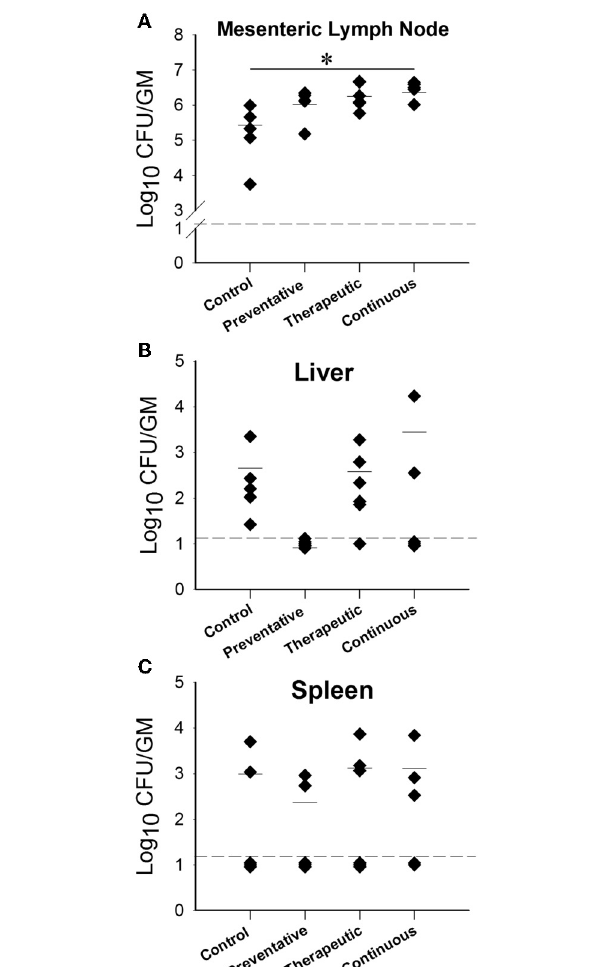
FIGURE 7 | Cytokine profiles of different Lactobacillus casei ATCC 334 treatments at 12 weeks post oral M. avium subsp. paratuberculosis K10 infection. Graphs A–C ( A . INF γ , B . IL-10, C . IL-12) depict cytokine levels of mice orally infected with two consecutive doses of 10 9 CFU of M. avium subsp. paratuberculosis K10 and treated with different ATCC 334 treatments. At 12 weeks post infection, mouse spleens were collected and splenocytes were isolated and stimulated with Johnin Purified Protein Derivative (PPD) or media only for 48h. Supernatant was collected and used for cytokine quantification by luminex bead array. Graph bars reflect the mean of each treatment group and their standard deviation. Levels were calculated by subtracting individual PPD stimulated levels from their background levels. Significant differences among groups are reflected by ∗ p < 0 .